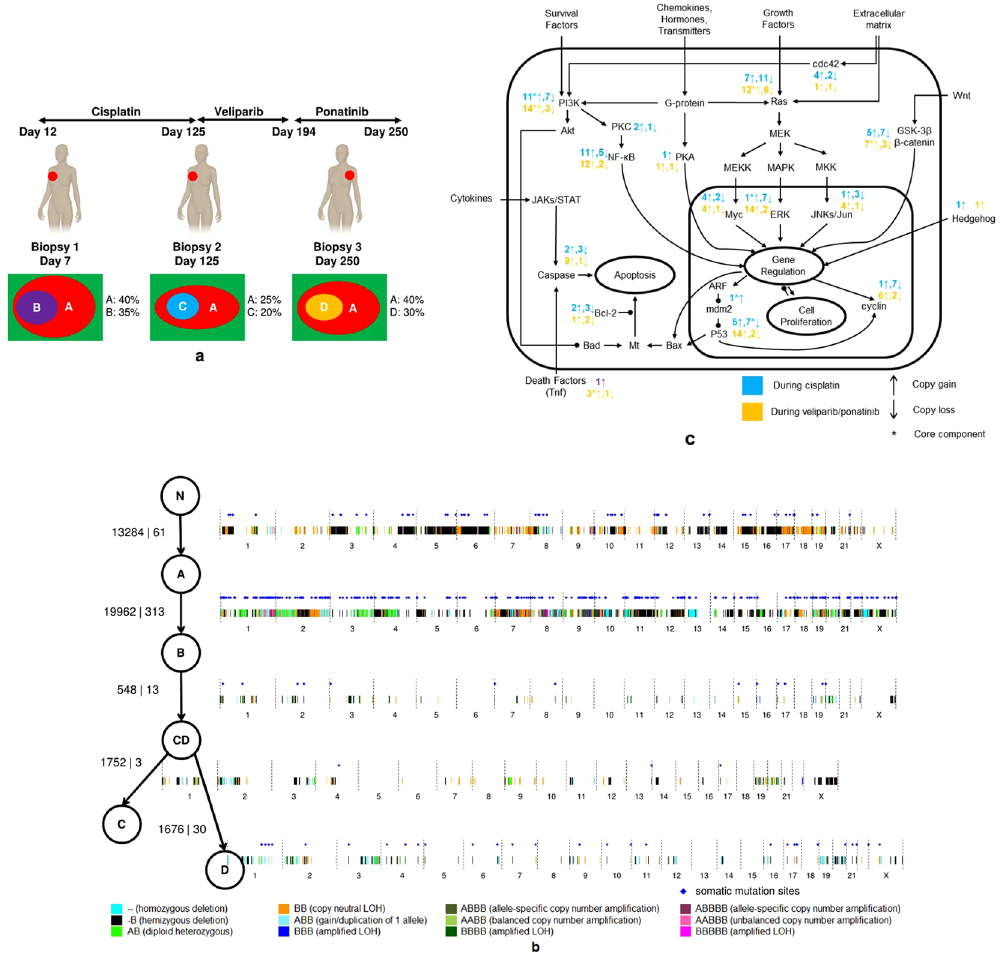
Figure 3. Experiments and results from joint analysis of three biopsies from the same patient. ( a ) The collection of the three biopsies from the same patient during three stages of treatment and the inferred tumor clones in the biopsies. ( b ) The recovered phylogenetic tree and the mutations accumulated on each edge. The mutations are shown on a genome-wide plot, and the two numbers on each edge are the number of germline heterozygous sites affected by these CNAs and the number of SNVs. ( c ) Signal pathways (a simplified version of signal transduction pathways from Wikipedia), and the number of genes with copy number changes (copy gain and copy loss) in different stages of cancer progression. * Denotes at least one of the mutated genes is a core component of the signaling